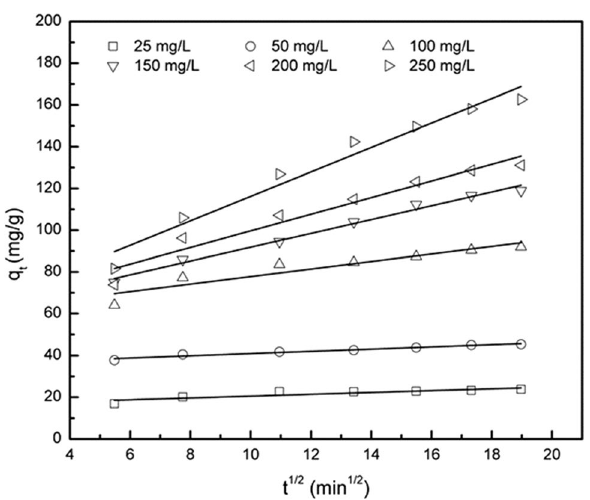
Fig. 8 Intraparticle diffusion model for adsorption of MB on BNH- CM surface